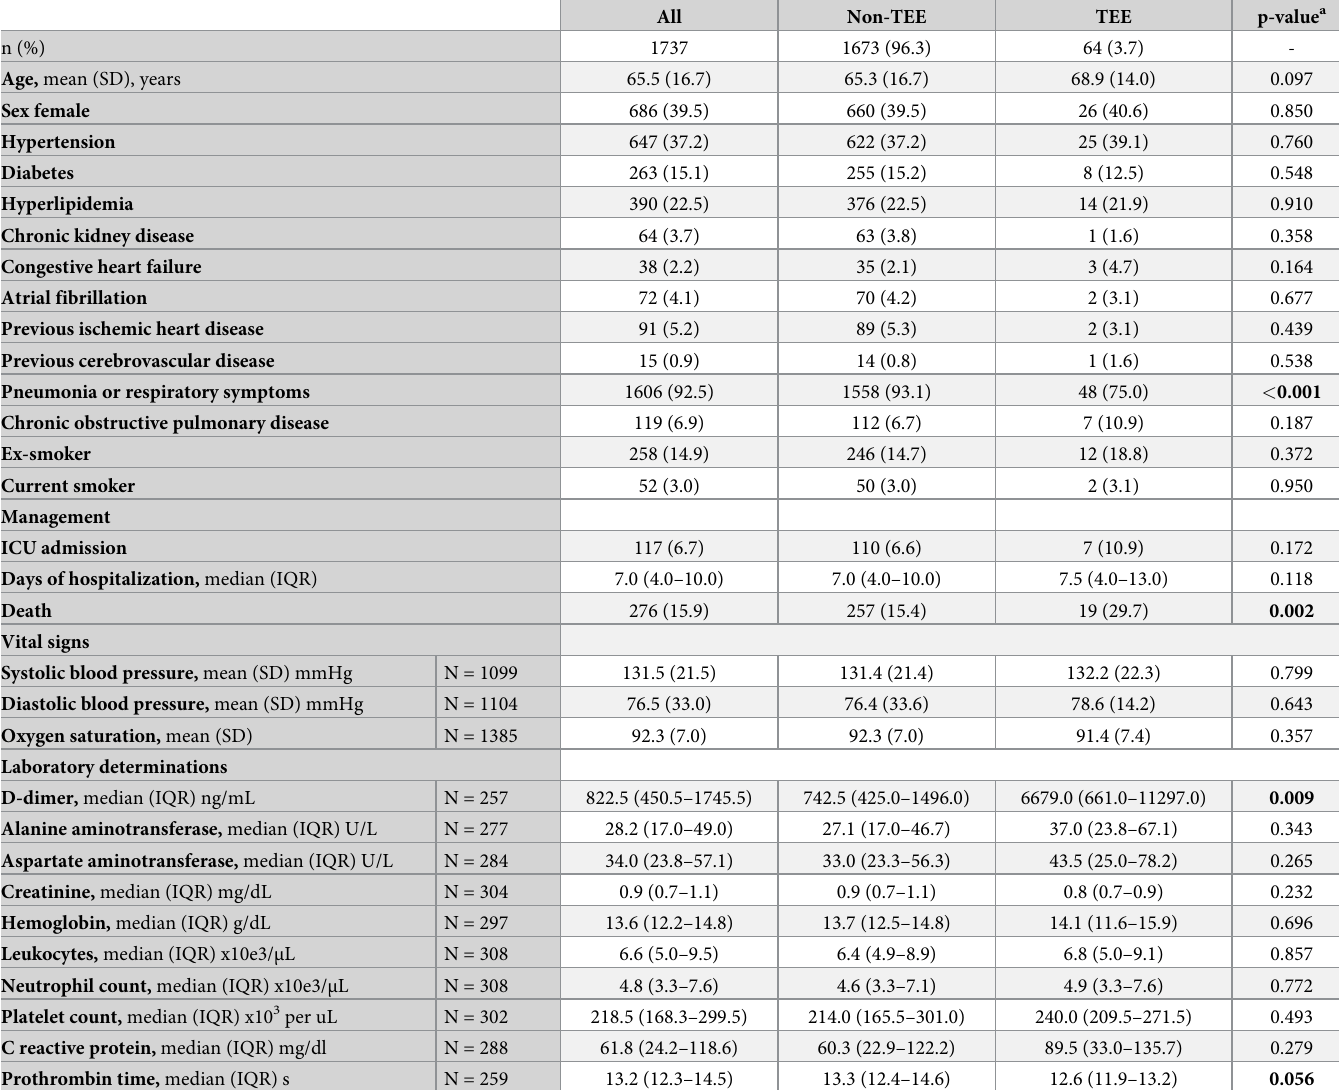
Table 1. Description and frequency of baseline characteristics, comorbidity, clinical, laboratory variables in patients with thromboembolic events.